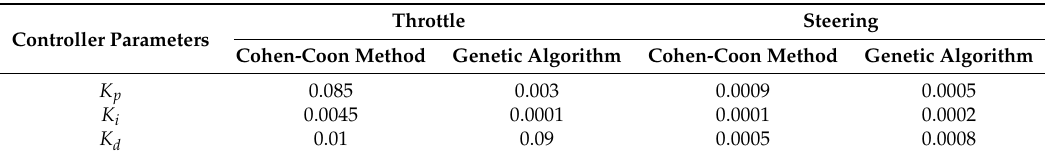
Table 5. Quantitative comparison of Cohen-Coon method and Genetic algorithm for tuning the PID parameters. Cohen-Coon method is manual tuning as compared to Genetic algorithm in which the tuning of PID parameters are obtained by defining the objective function and solve as an optimization problem [24].